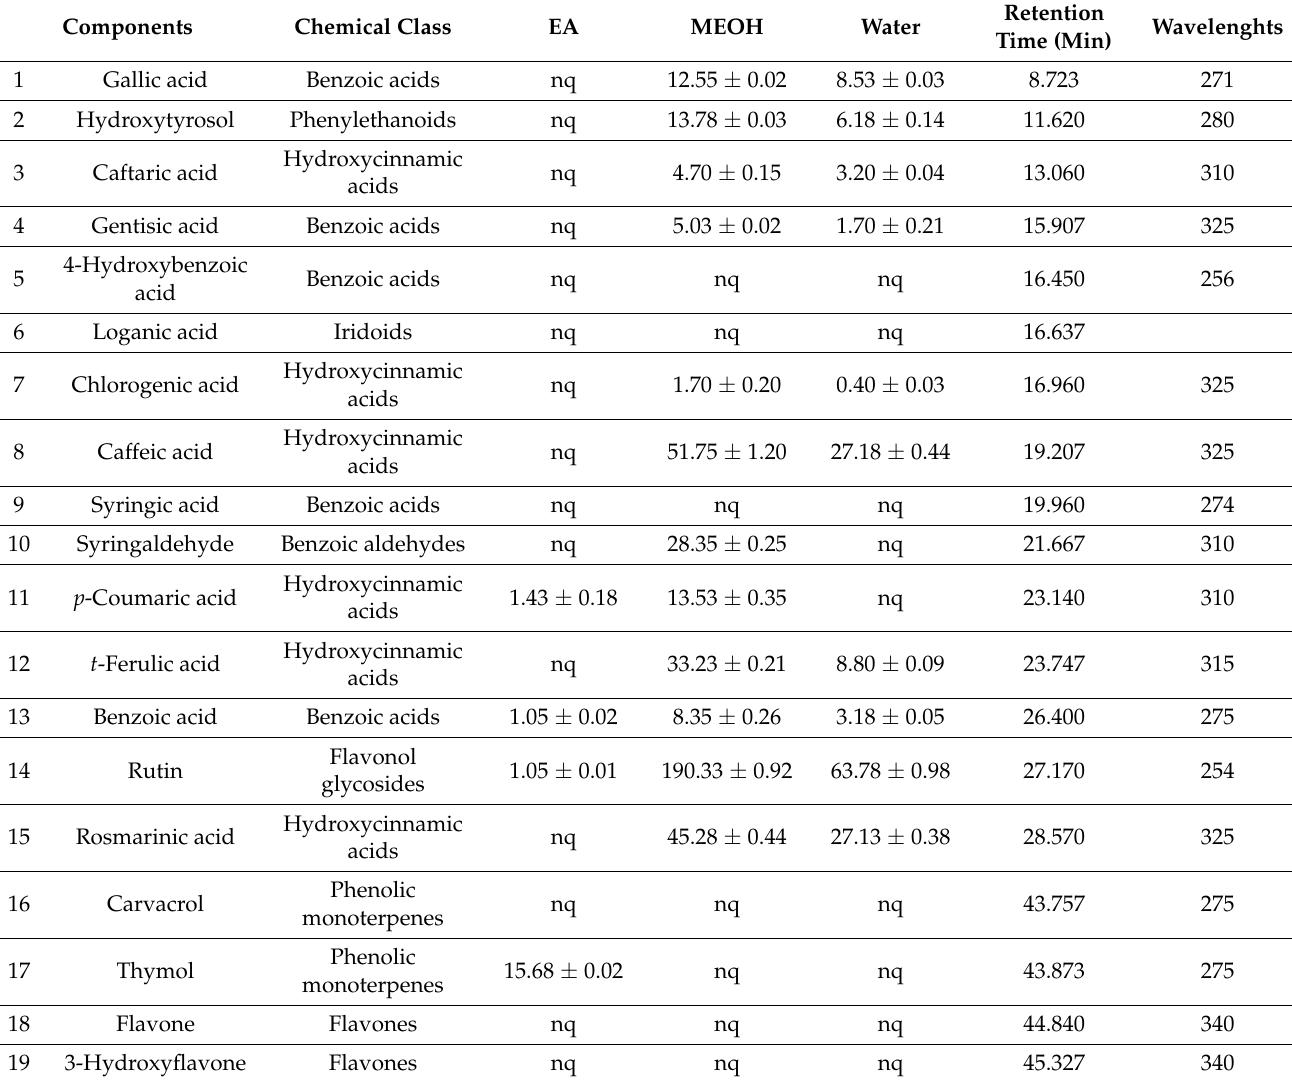
Values are reported as mean ± SD of three parallel experiments. TPC: Total phenolic content; TFC: Total flavonoid content; GAE: Gallic acid equivalent; RE: Rutin equivalent. Different letters indicate significant differences in the tested extracts ( p < 0.05). Table 2. Content in specialized metabolites ( µ g/mg) of the tested P. quercetorum extracts. All identified phytochemicals have been identified through comparison with pure standards. Most of them have been quantified in at least one extract. Quantitative determination of the compounds was performed via DAD detector at 254–340 nm